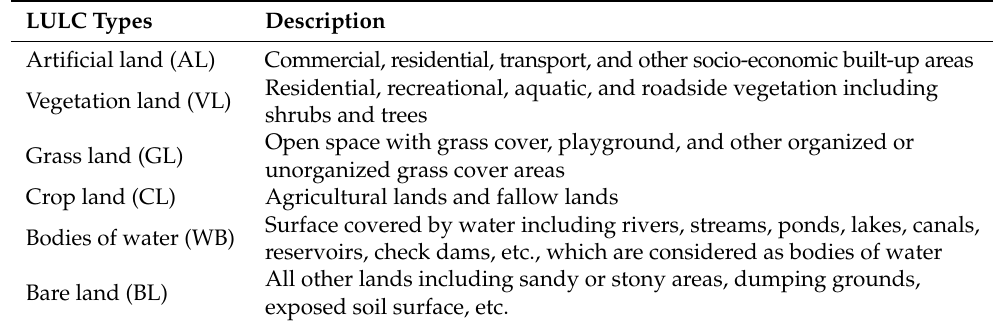
Table 2. Description of LULC types used in the classification.